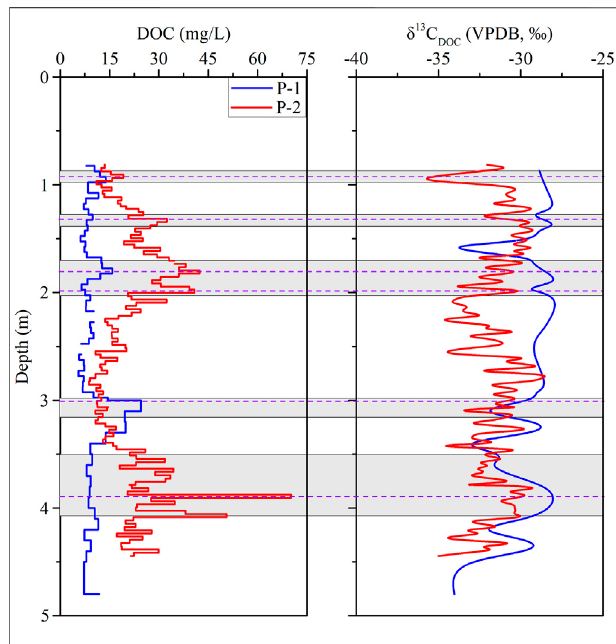
FIGURE 8 | The DOC behaviors of ground ice along depth in both pro fi les. The gray bars represent the prominent DOC accumulation